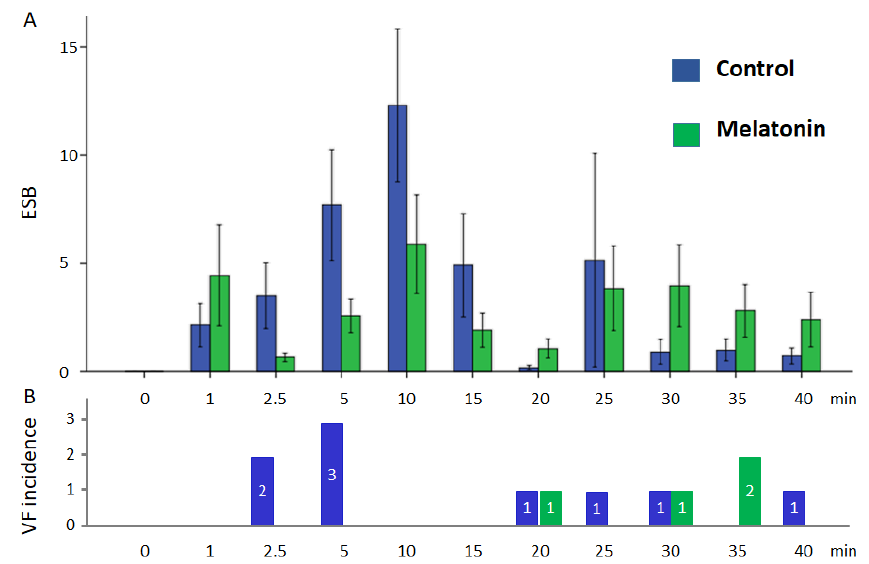
Figure 2. Ventricular arrhythmias in control and melatonin groups during coronary occlusion: ( A ) extrasystolic burden (mean ± SEM); ( B ) number of cases of VF incidence in groups.